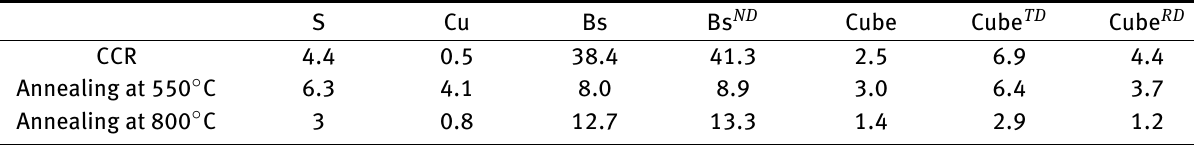
Table 2: Volume fractions (%) of the texture components in different